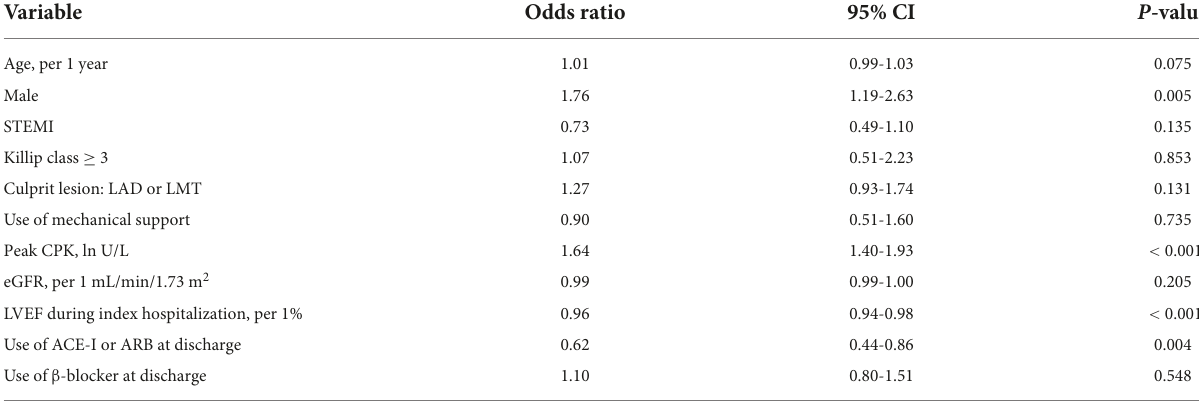
TABLE 2 Logistic regression analysis to identify clinical factors associated with LVEF category decline over the 6 months after AMI. Variable